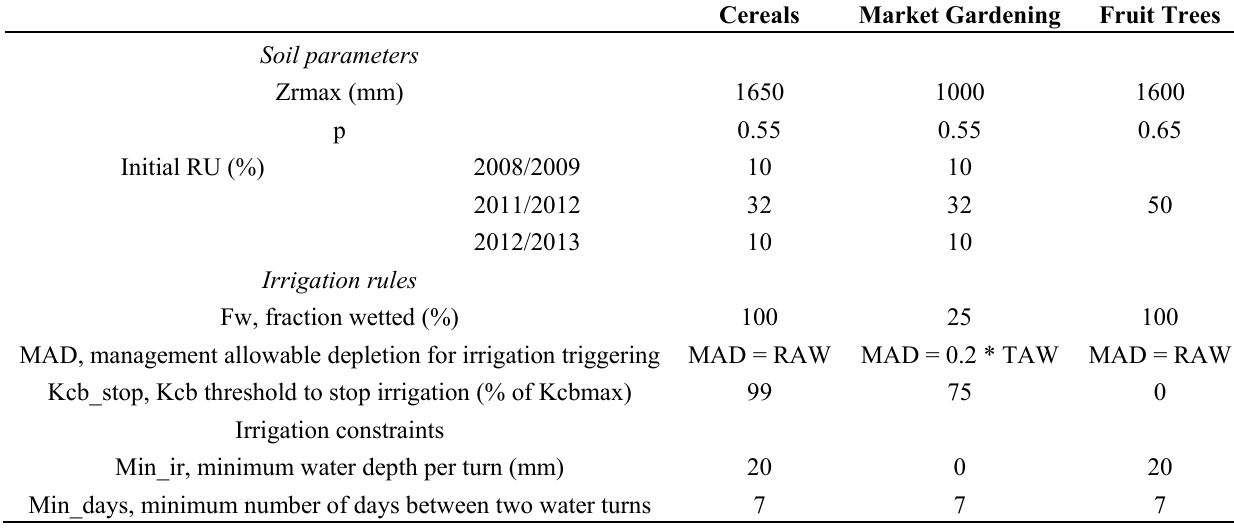
Table 3. Soil and Irrigation parameters used for spatialization. Cereals Market Gardening Fruit